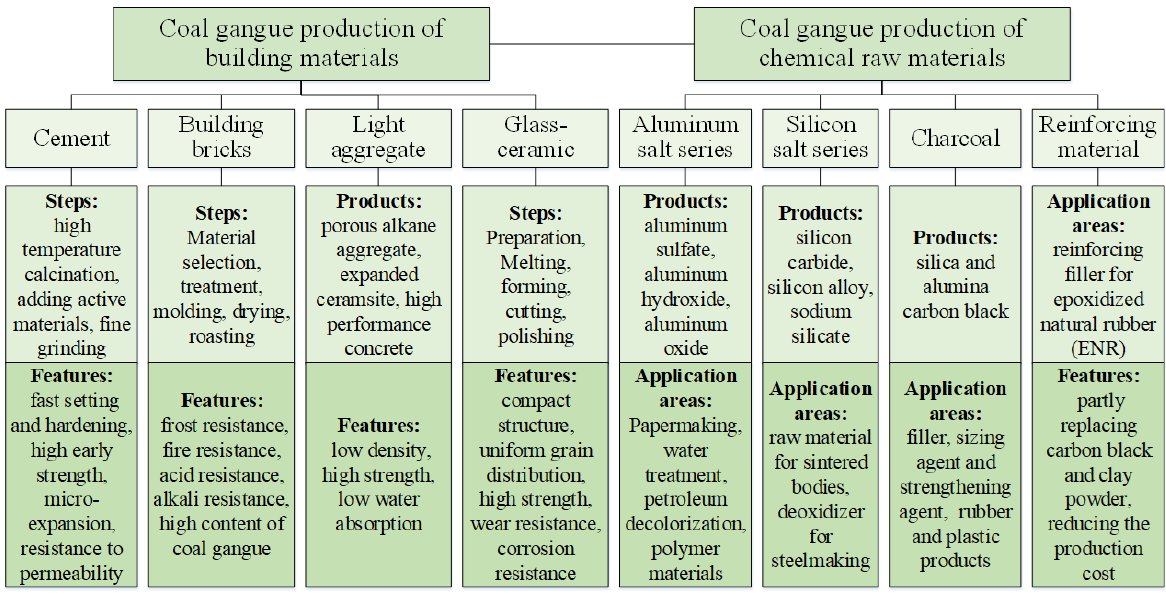
Figure 1. The utilization of coal gangue on the